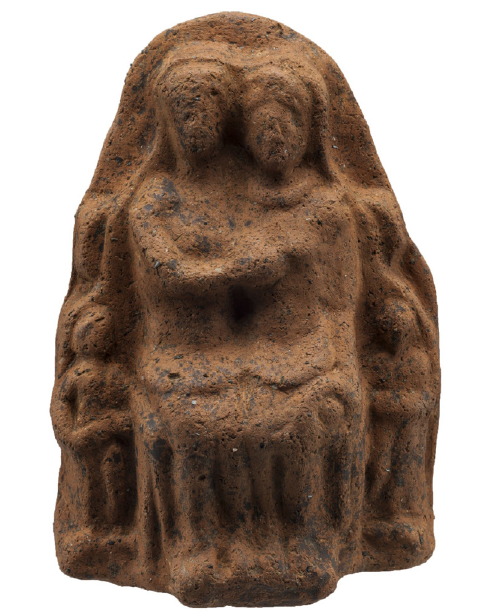
Figure 9. Satricum. © MiBAC. Museo Nazionale Etrusco di Villa Giulia. Foto Mauro Benedetti. From Pedrucci, “Maternità e allattamento”.